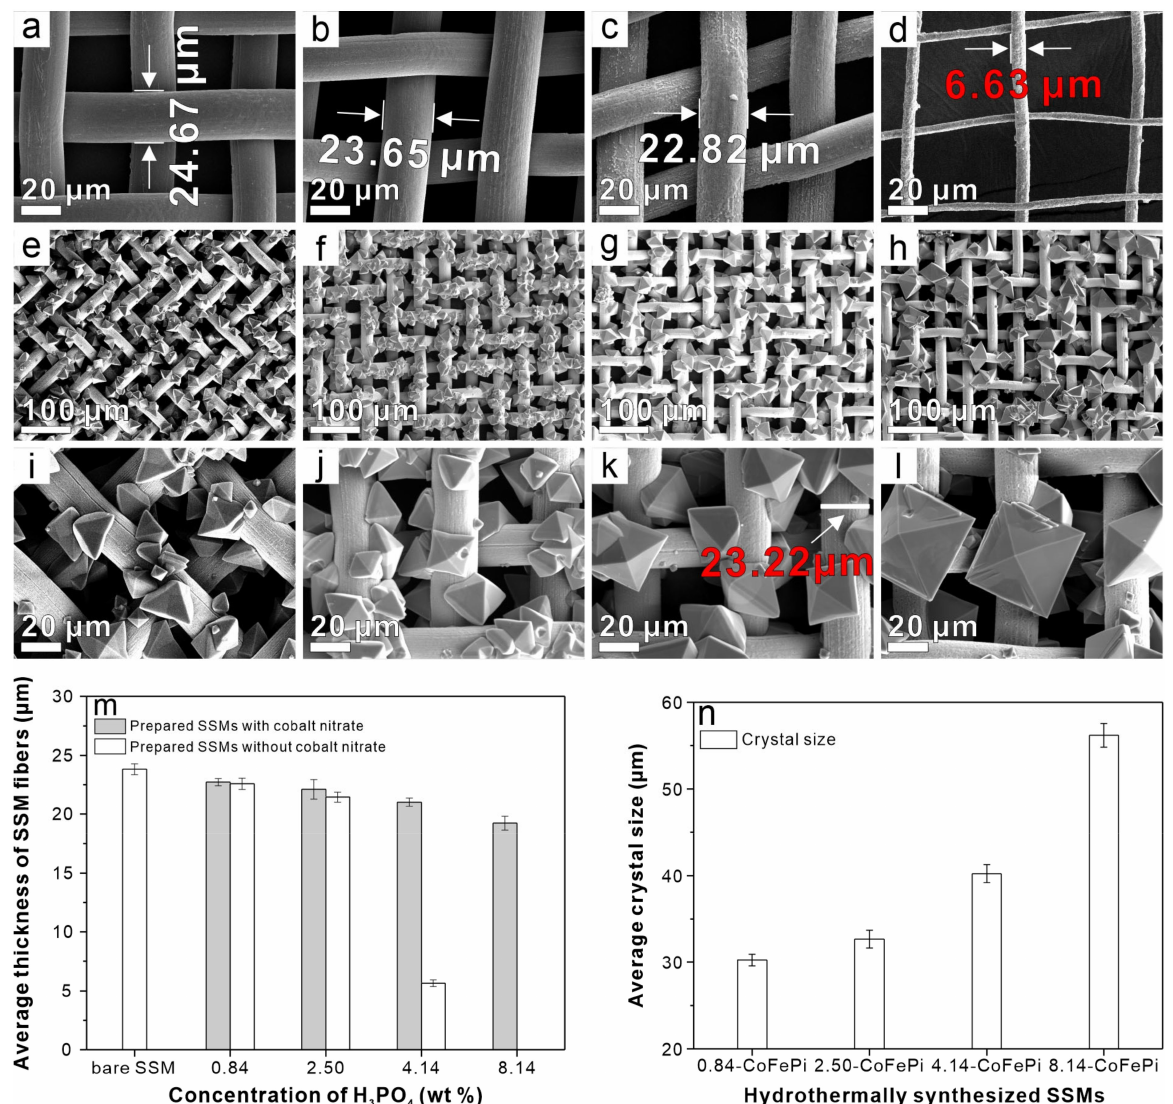
Figure 1. The SEM images of ( a ) bare SSM; hydrothermally synthesized SSMs under phosphoric acid aqueous solutions ( b ), SSM-0.84, ( c ) SSM-2.50, ( d ) SSM-4.14; SEM images of hydrothermally synthesized SSMs under cobalt nitrate and phosphoric acid aqueous solutions ( e , i ) 0.84-CoFePi, ( f , j ) 2.50-CoFePi, ( g , k ) 4.14-CoFePi, and ( h , l ) 8.14-CoFePi; ( m ) Average fiber thickness of prepared SSMs and ( n ) Crystalline size of hydrothermally synthesized crystals on